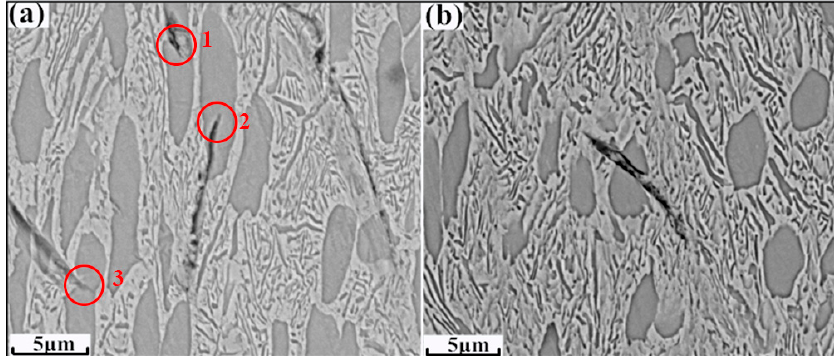
Figure 4. Profile-view SEM images close to the fracture surface of samples ( a ) BM (cracks inhibition in red circles)and ( b ) HR-BM.